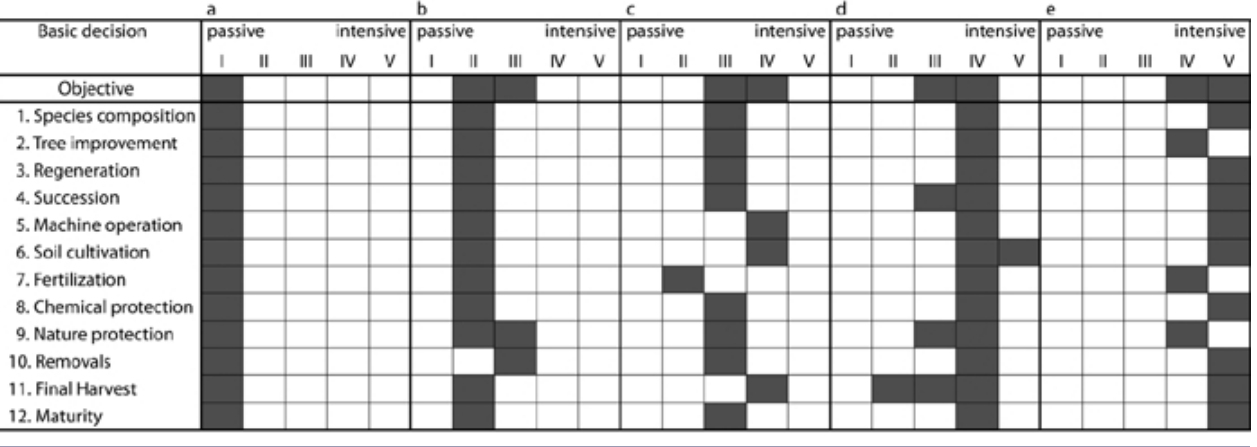
Fig. 1. Evaluation of current forest management in different regions of Europe using 12 decisions on silvicultural operations and an intensity grade from passive (1) to intensive (5). Case studies are (a) Bialowieza National Park, Poland; (b) European beech in Baden-Wuerttemberg, Germany; (c) mixed forests dominated by Norway spruce in northern Sweden; (d) Sitka spruce forests in Scotland, and (e) Eucalyptus in